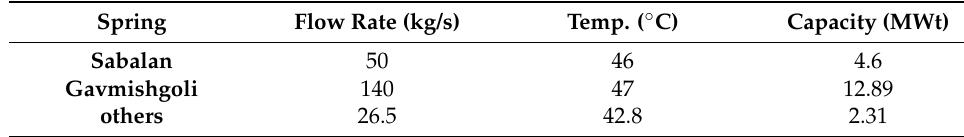
Table 3. Characteristics of hot springs in Sarein.